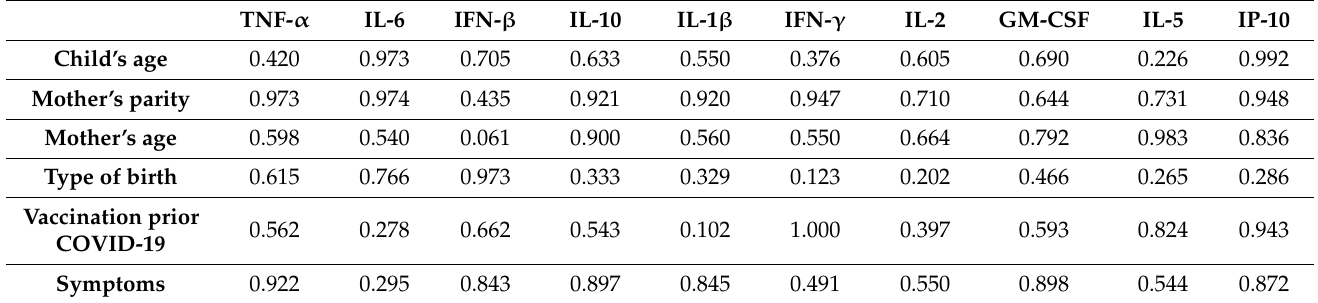
Table 6. p -value in Spearman’s correlation in the group of COVID-19